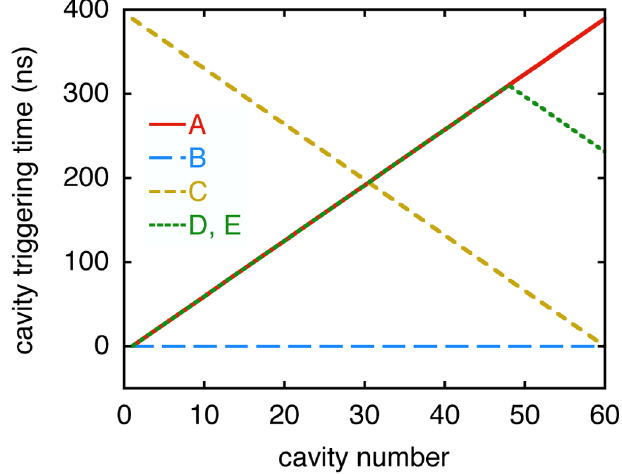
FIG. 5. (Color) Cavity-triggering sequences used to generate the five current-pulse shapes plotted by Fig. 4. For current shapes A, B, C, and D, all the cavities are charged to 200 kV. For shape E, cavities 49–60 are charged to 100 kV.